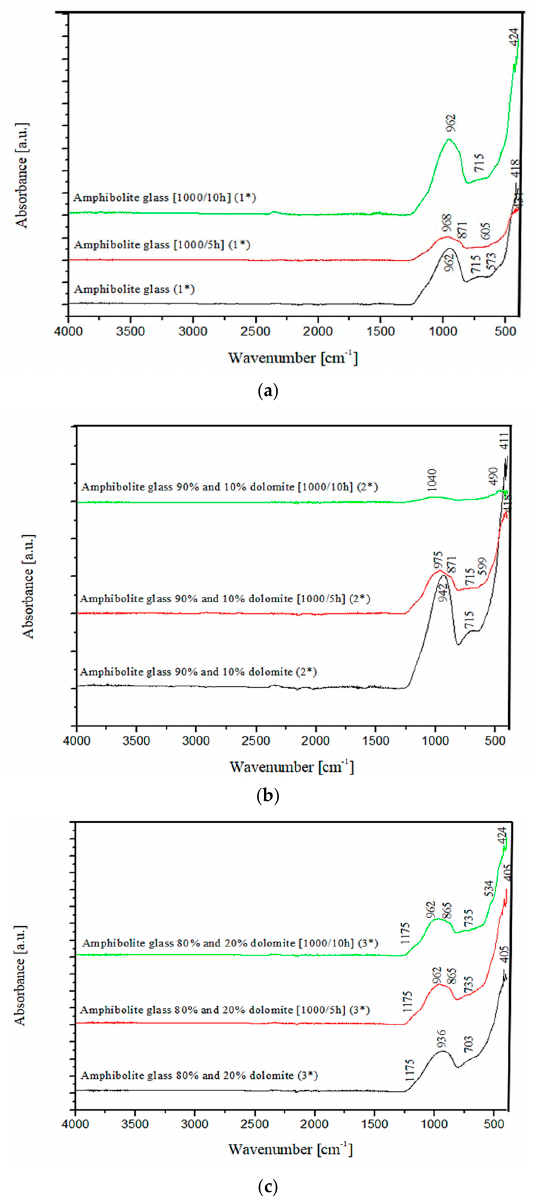
Figure 9. SEM-EDS image and analysis of amphibolite glass modified with 20 wt.% dolomite addition (Set 3*) after crystallization at 1000 °C for 10 h.